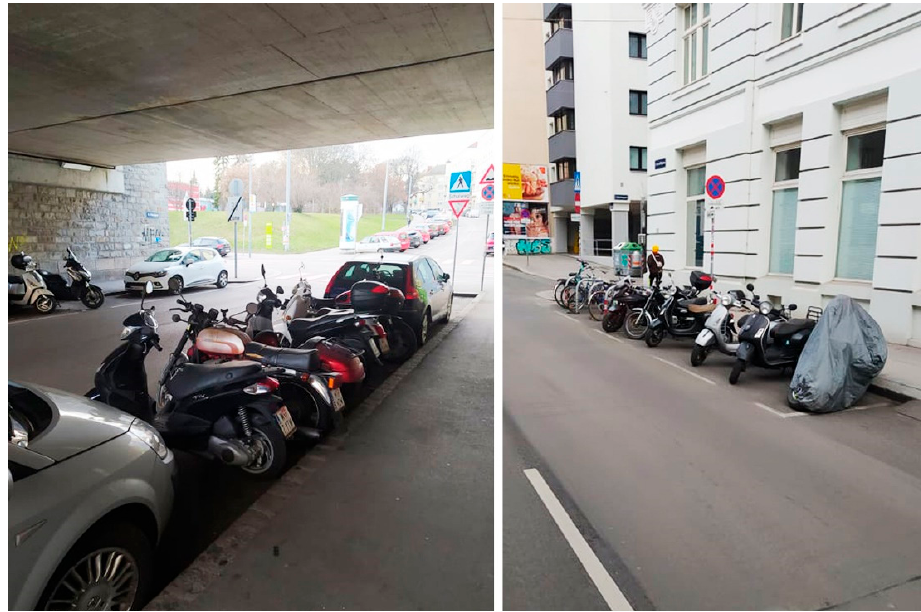
Figure 6. Separate parking zones for PTW bikes in Vienna. Source: Authors’ archives (photo Ł . Ryga łł o).